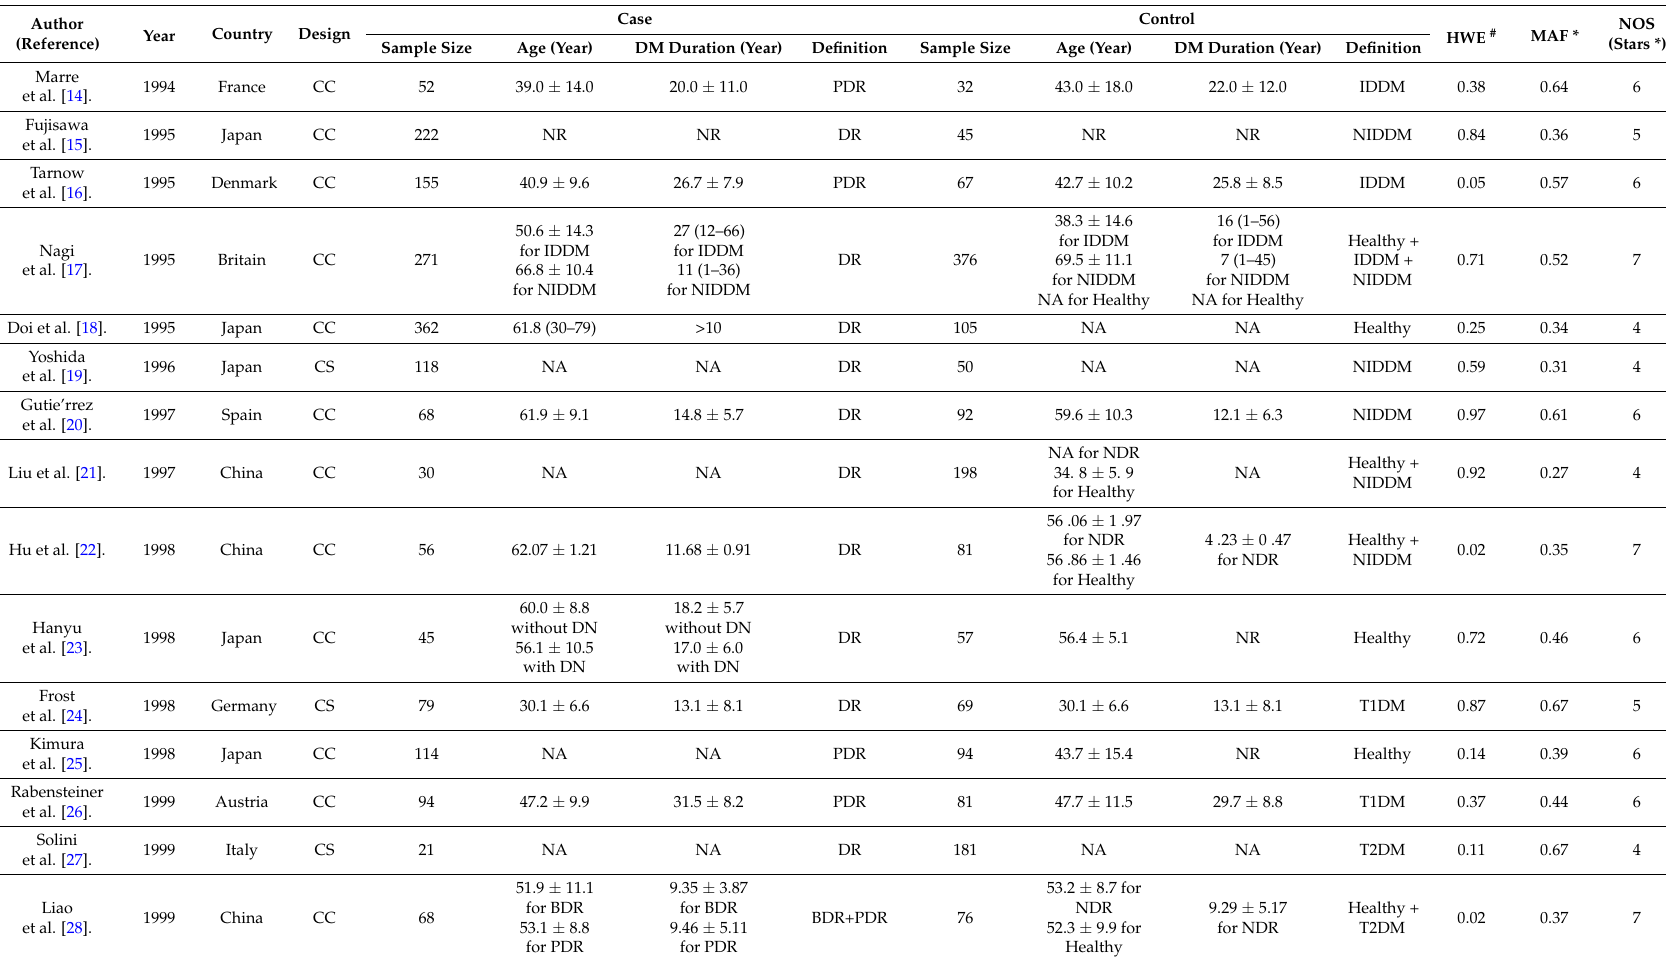
Table 1. Characteristics of published studies included in the